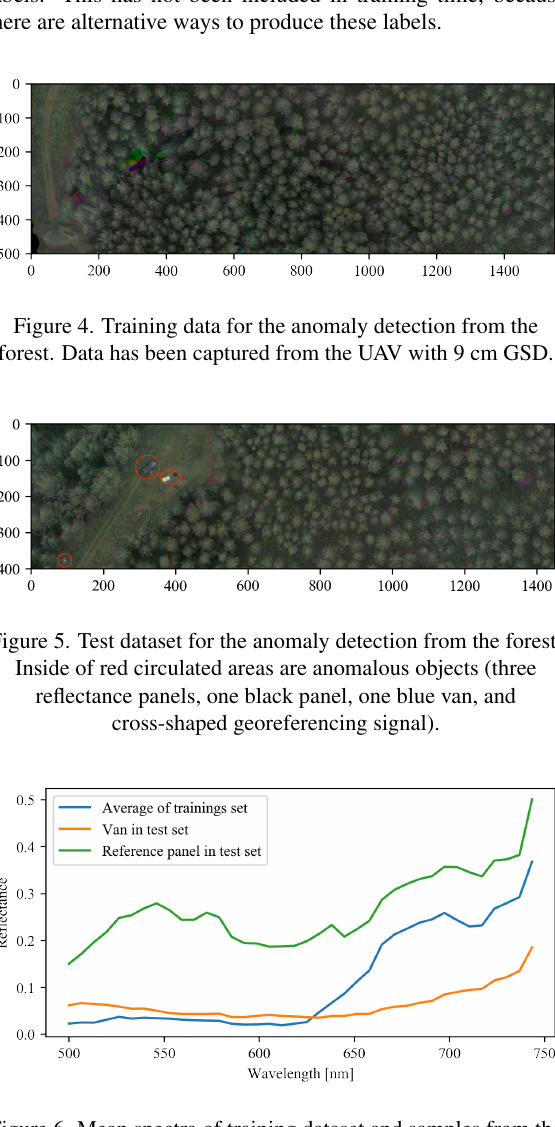
Figure 6. Mean spectra of training dataset and samples from the van and the reflectance panel (nominal reflectivitiy of